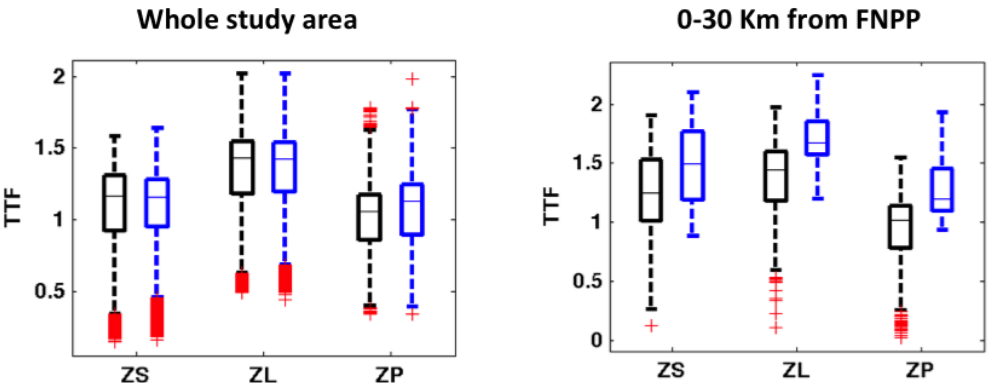
Figure 11. Boxplots of the Trophic Transfer Factor (TTF) calculated over 2011 for the three groups of zooplankton and for the two different spatial scales. The dark color represents the accident situation and the blue color represents the no-accident situation. On each box, the central mark is the median, the edges of the box are the 25th and 75th percentiles, the whiskers extend to the most extreme data points not considered outliers, and outliers are plotted individually (the red